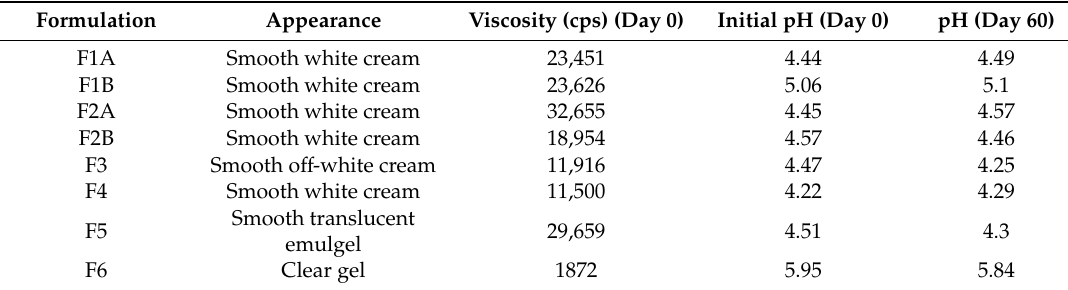
Table 5. Viscosity and pH of ibuprofen creams and